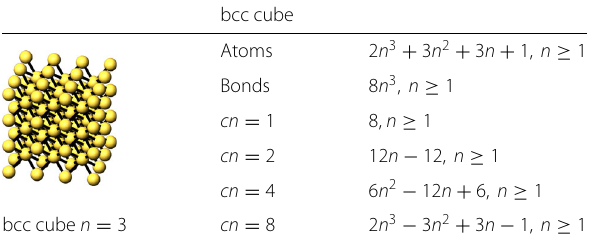
Table 2 Magic formulas for the bcc cube